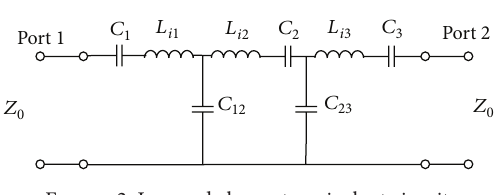
Figure 3: Calculated 𝑆 parameters.